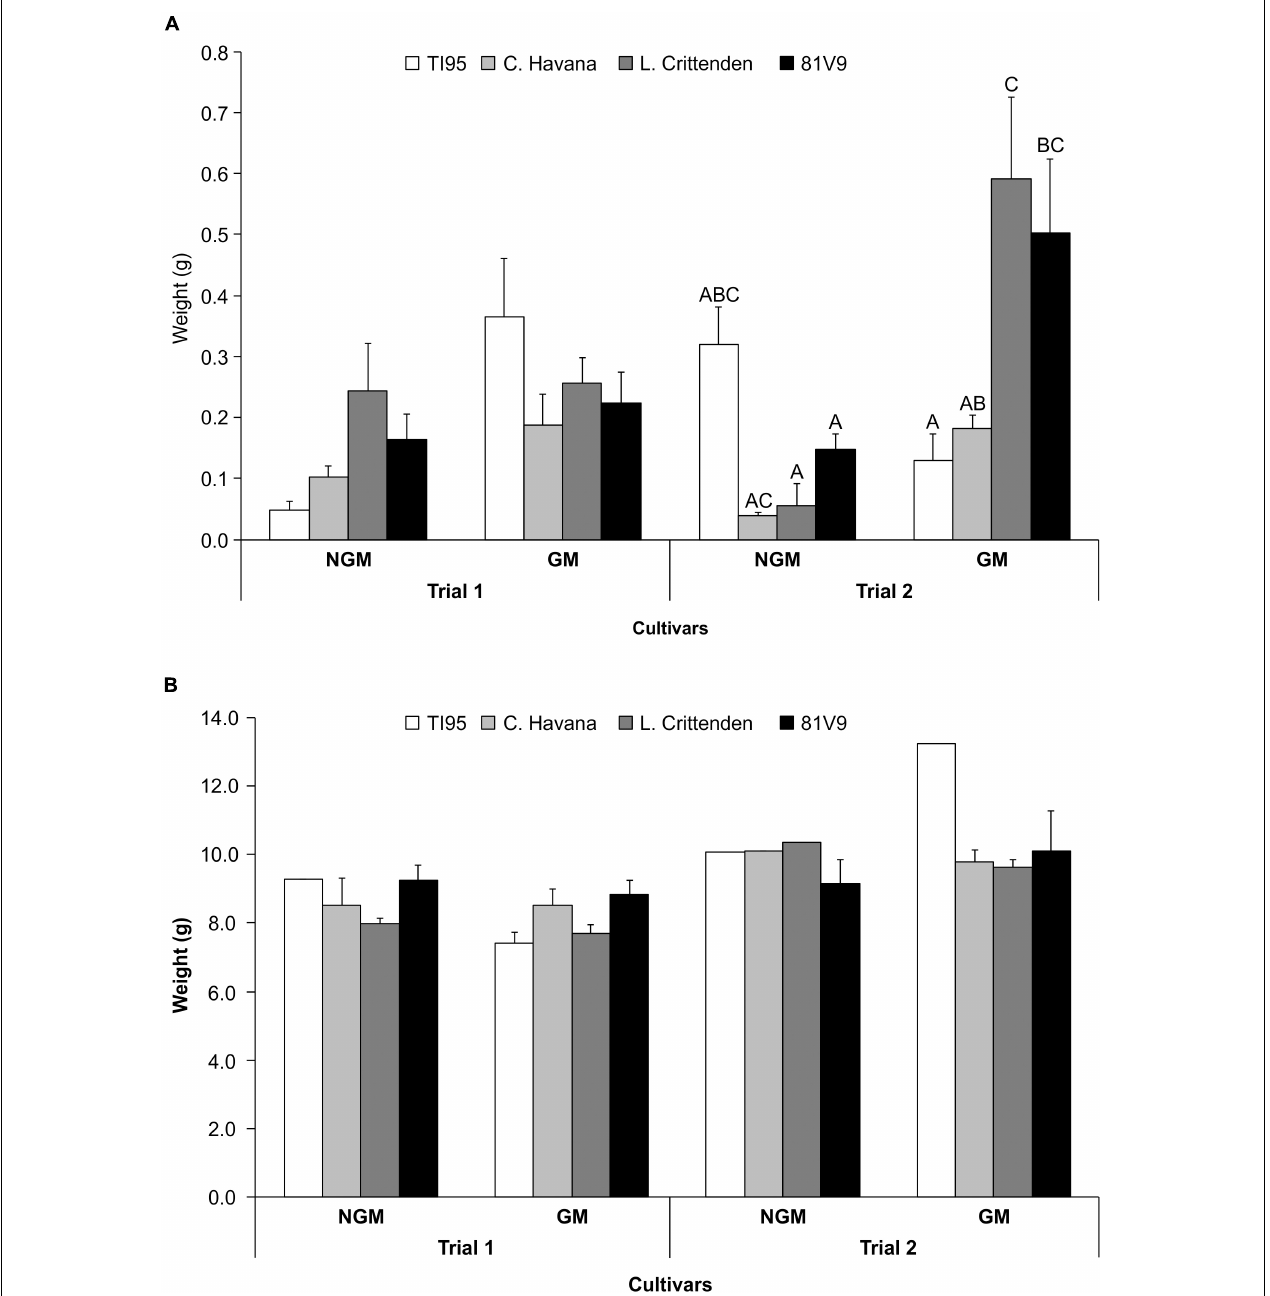
FIGURE 5 | PFA has no effect on final tobacco hornworm weight in field conditions. Mean larval weight ± S.E. on field-grown tobacco ( N = 20 larvae/cultivar) in two field trials. (A) 7 days hornworm larval weight and (B) pre-pupal larval weight (after approximately 20 days). Bars with the same letter in (A) trial 2 are not statistically different, no letters in (A) trial 1 and in (B) trials 1 and 2 indicates no statistical difference among all treatments (2-way ANOVA, Tukey’s pairwise comparison, P > 0.05).